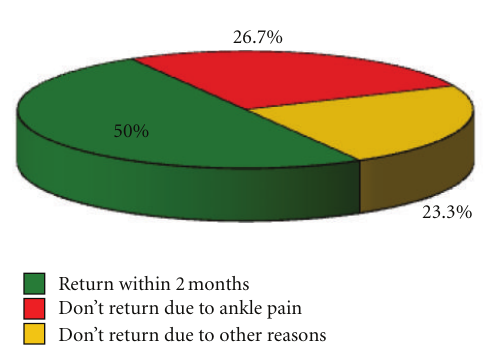
Figure 10: Return to previous sport activity. 45 of 59 cases (76%; range: 70 to 92%) a successful result was